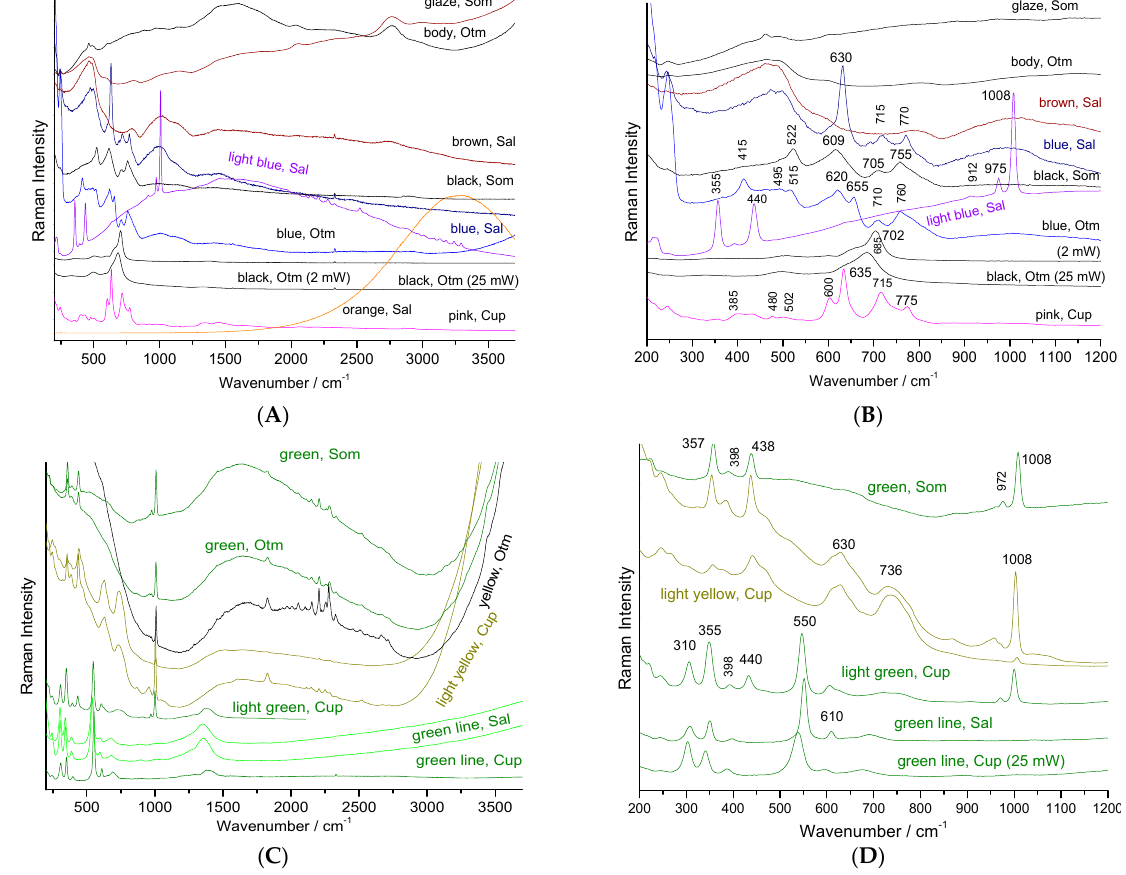
Figure 5. Representative Raman spectra and background recorded on 20th century porcelain with complex colored décor (Figure 3d–g): ( A ) and ( C ): full spectral window; ( B ) and ( D ): zoom in the 200–1200 cm − 1 range. Som: Figure 3e; Sal: Figure 3f; Cup: Figure 3d; Otm: Figure 3g. Full spectral range is given on the left and a zoom between 200 and 1200 cm − 1 on the right side.